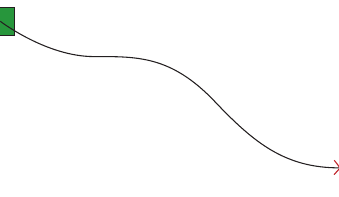
Figure 2. A simple demonstration where the tip of a robot arm starts at the red cross in the lower right corner and moves over the table until it is po- sitioned over the green cube. The demonstration can be interpreted in a number of fundamentally different